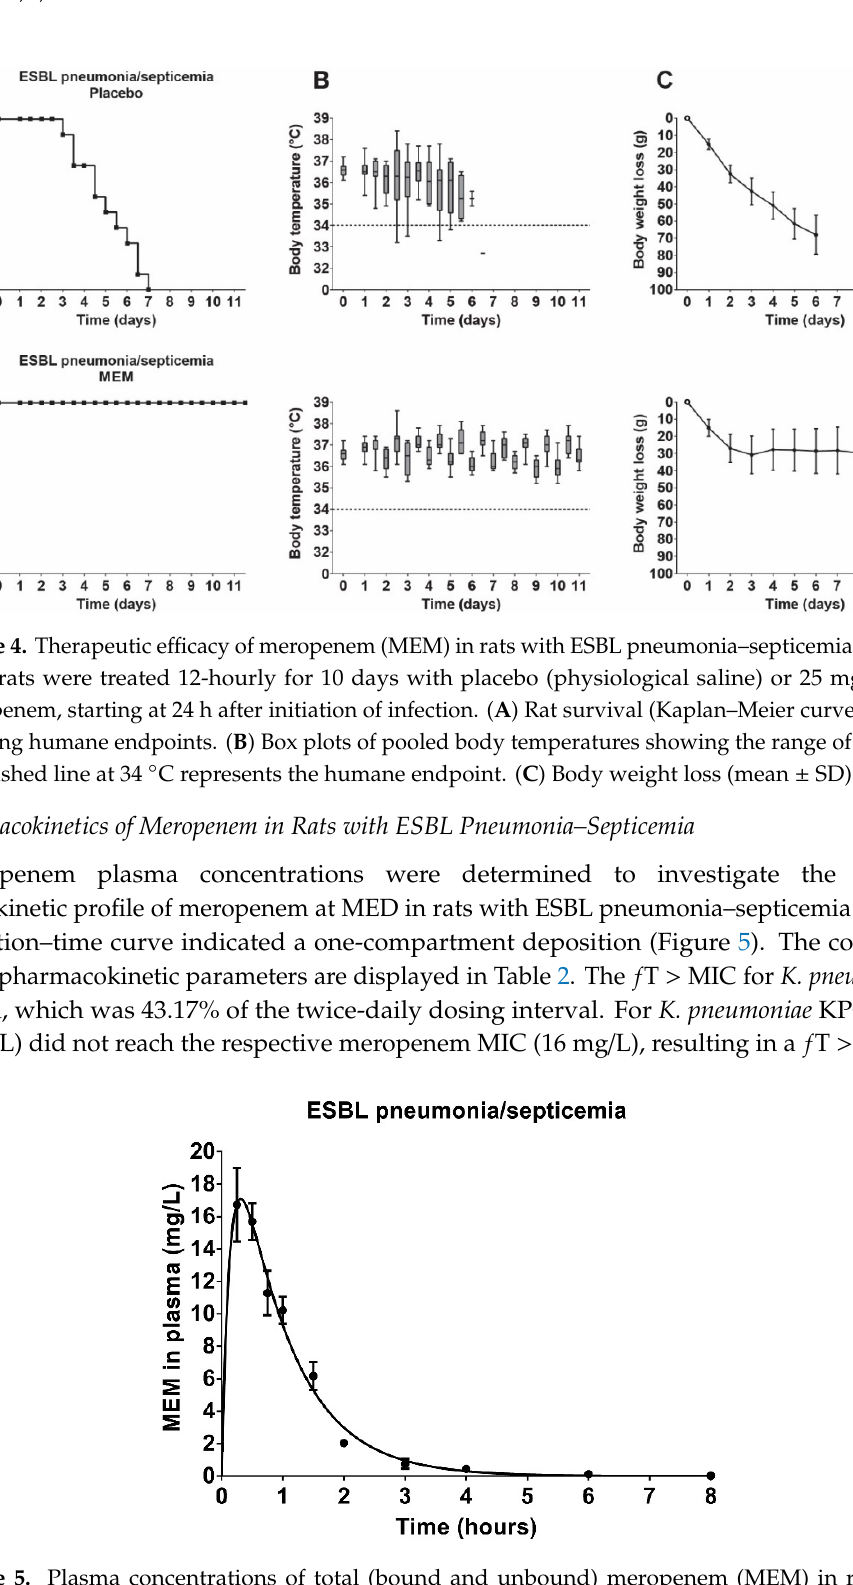
Figure 5. Plasma concentrations of total (bound and unbound) meropenem (MEM) in rats with ESBL pneumonia–septicemia. Rats were treated 12-hourly with 3 consecutive doses of 25 mg/kg/day meropenem, starting at 24 h after initiation of infection. The concentration–time curve predicted by a one-compartment model of extravascular administration was imposed over the observed concentrations at each time point in 3 rats (mean ± SEM).